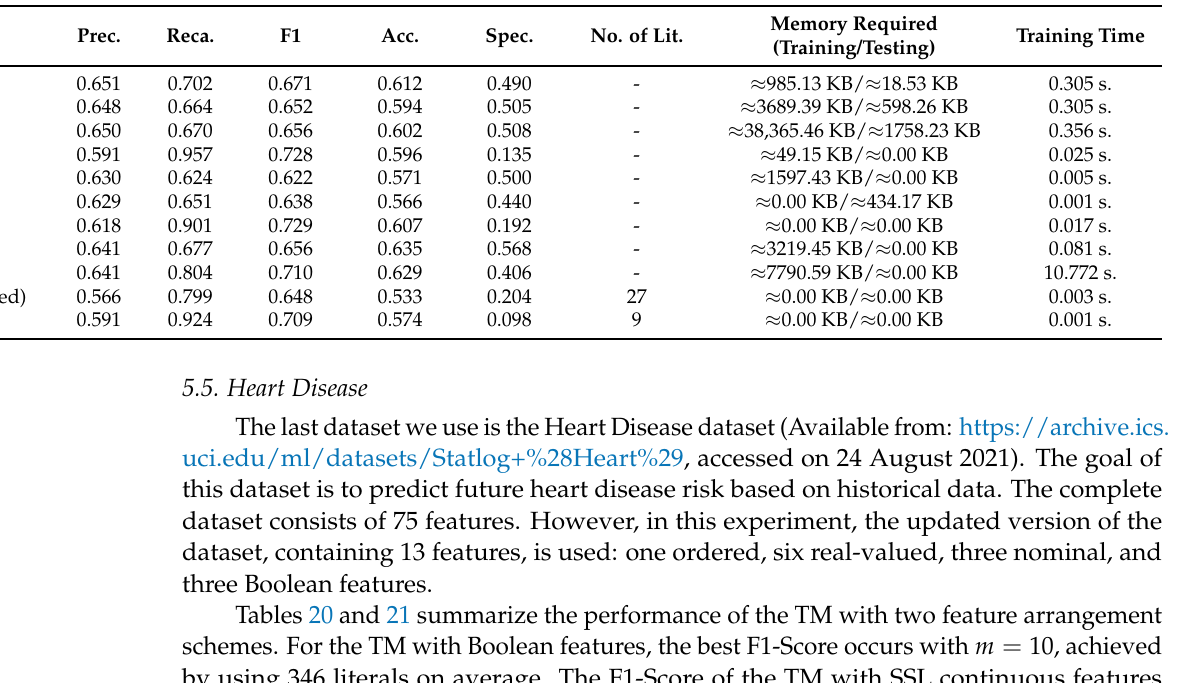
Table 19. Performance comparison for Liver Disorders